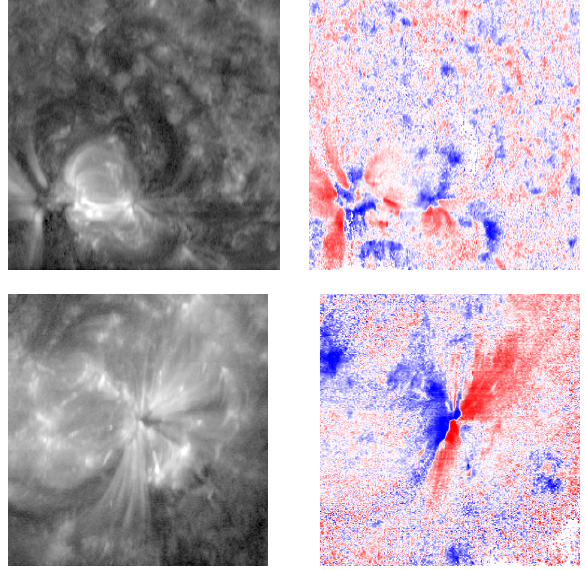
Fig. 3. Two examples of sunspot plumes from 23 March 1996 (top, FOV=300 00 × 300 00 ) and from 16 November 2006 (bottom, FOV=287 00 × 300 00 ), shown as radiance map and as Doppler map. In both cases the sunspot was observed in Ne VIII